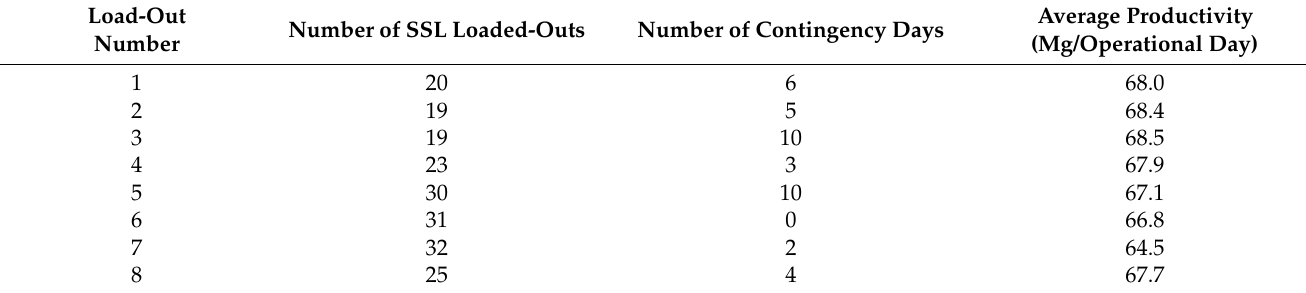
Table 2. Average load-out productivity for eight load-outs over a 49-week